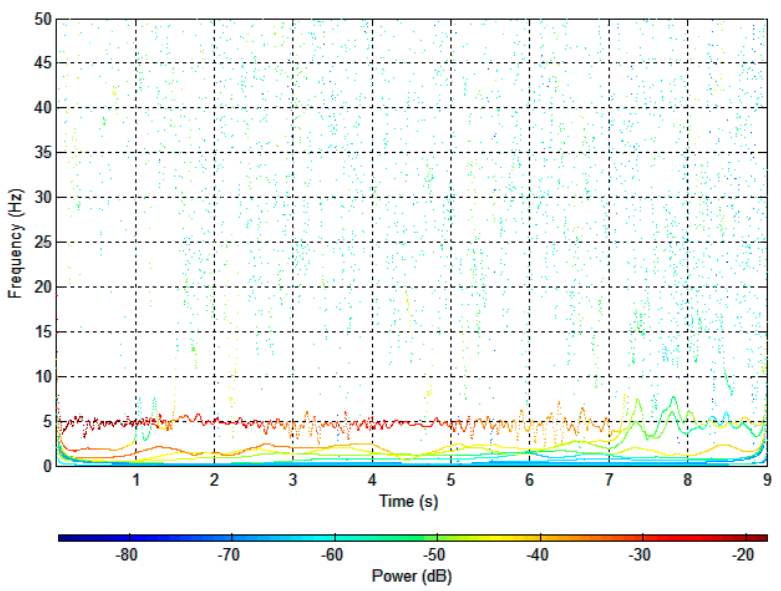
Figure 11. Hilbert spectrum of intrinsic mode functions (IMFs).